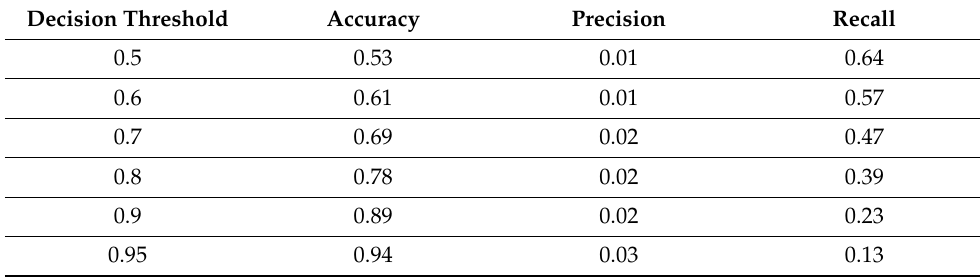
Table 4. Accuracy, precision, and recall of DCNN predictions for the final evaluation dataset. Decision